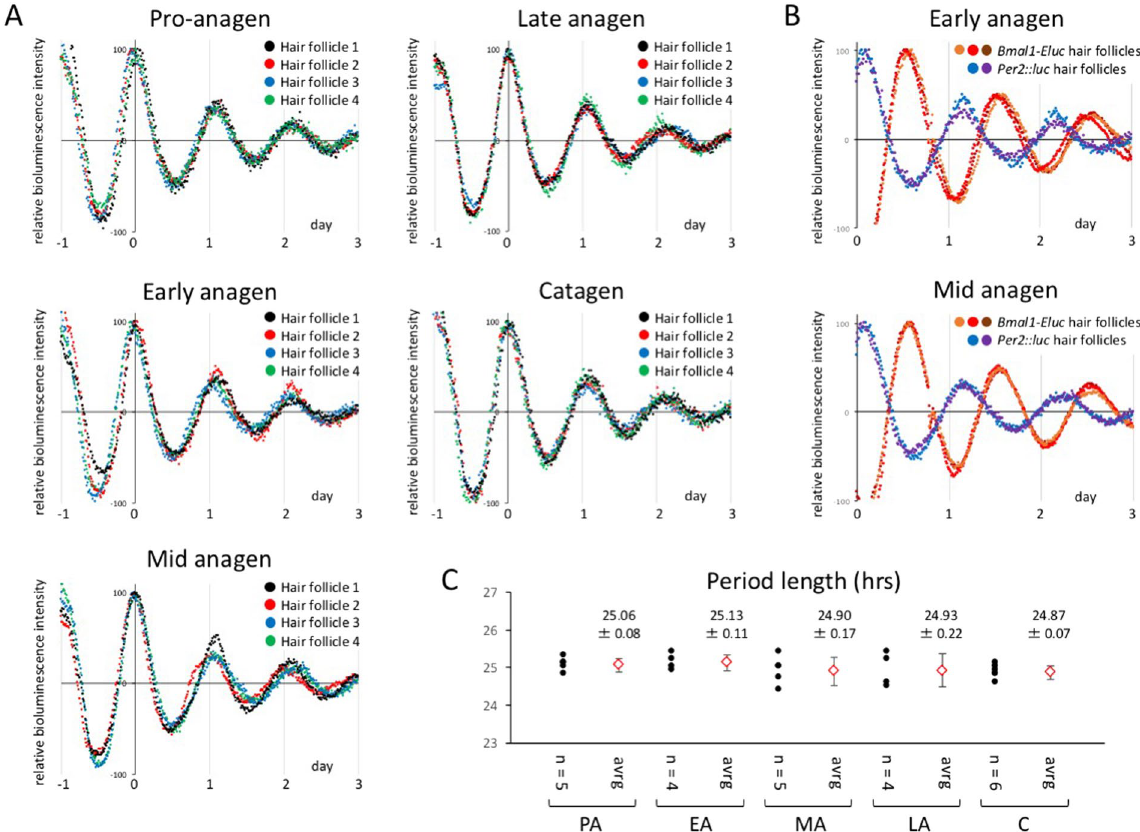
Figure 4. Comparison of circadian period length among hair cycle stages using mouse whisker follicles. ( A and B ) Whisker hair follicles were isolated by microdissection from a 6 week-old male Per2 Luc/ + mouse ( A ) and a 10 week-old male Bmal1-Eluc mouse ( B ). The hair cycle stage of whisker follicles was classified by morphology of the hair bulb and relative length of the hair shaft. The hair shaft was fixed on the bottom of a culture dish with silicone, and the immobilized hair tissue was then covered with luciferin-containing medium. After 2-day pre- culture, circadian synchronization was performed with 100 nM dexamethasone (DEX), and bioluminescence was measured in real time with photomultiplier tubes. Data sets were detrended by subtracting the 24 h running average from the raw data, and the first peak was then set to 100. Time 0 was defined as the time of the first peak ( A ) and the measurement start ( B ). The data are a representative of three independent experiments. ( C ) Period length calculated with a cosinor analysis. Black dots indicate the calculated period length of each hair follicle, and red dots represent the mean ± SD of period length